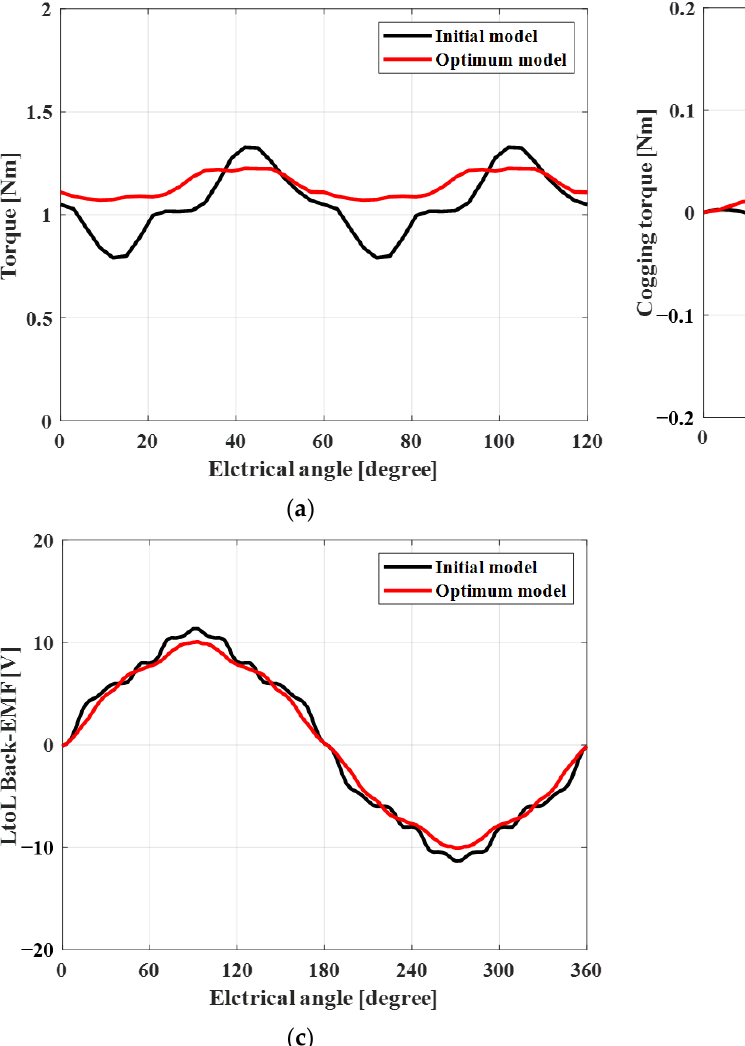
Figure 6. Waveform comparison of the initial model and optimum model ( a ) Torque waveform; ( b ) Cogging torque waveform; ( c ) Line to line B-EMF.